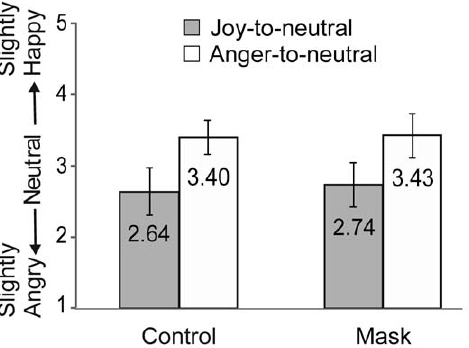
Figure 8. Results of Experiment 4. Mean scores for the neutral expressions at the end of the Joy-to-neutral and Anger-to-neutral video-clips without an inserted mask (control) and with (mask). Error bars indicate 6 1SD.